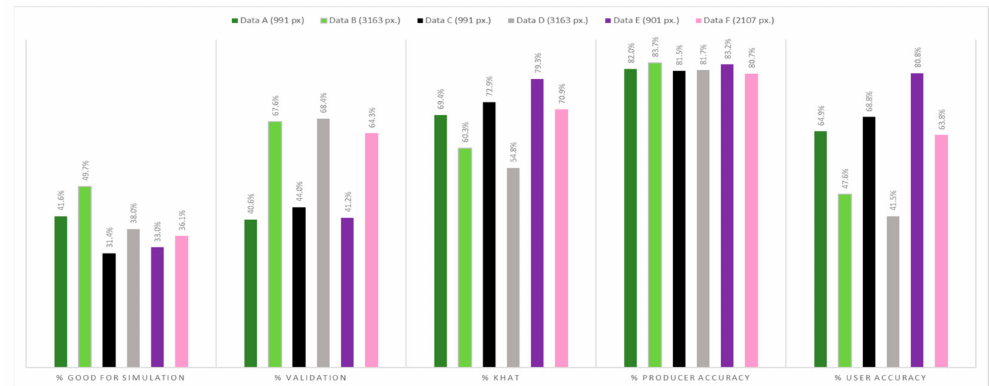
Figure 13. Percentage of validation against classification accuracy. The area extension of the six datasets, represented by different colors, is shown in Figure 7.